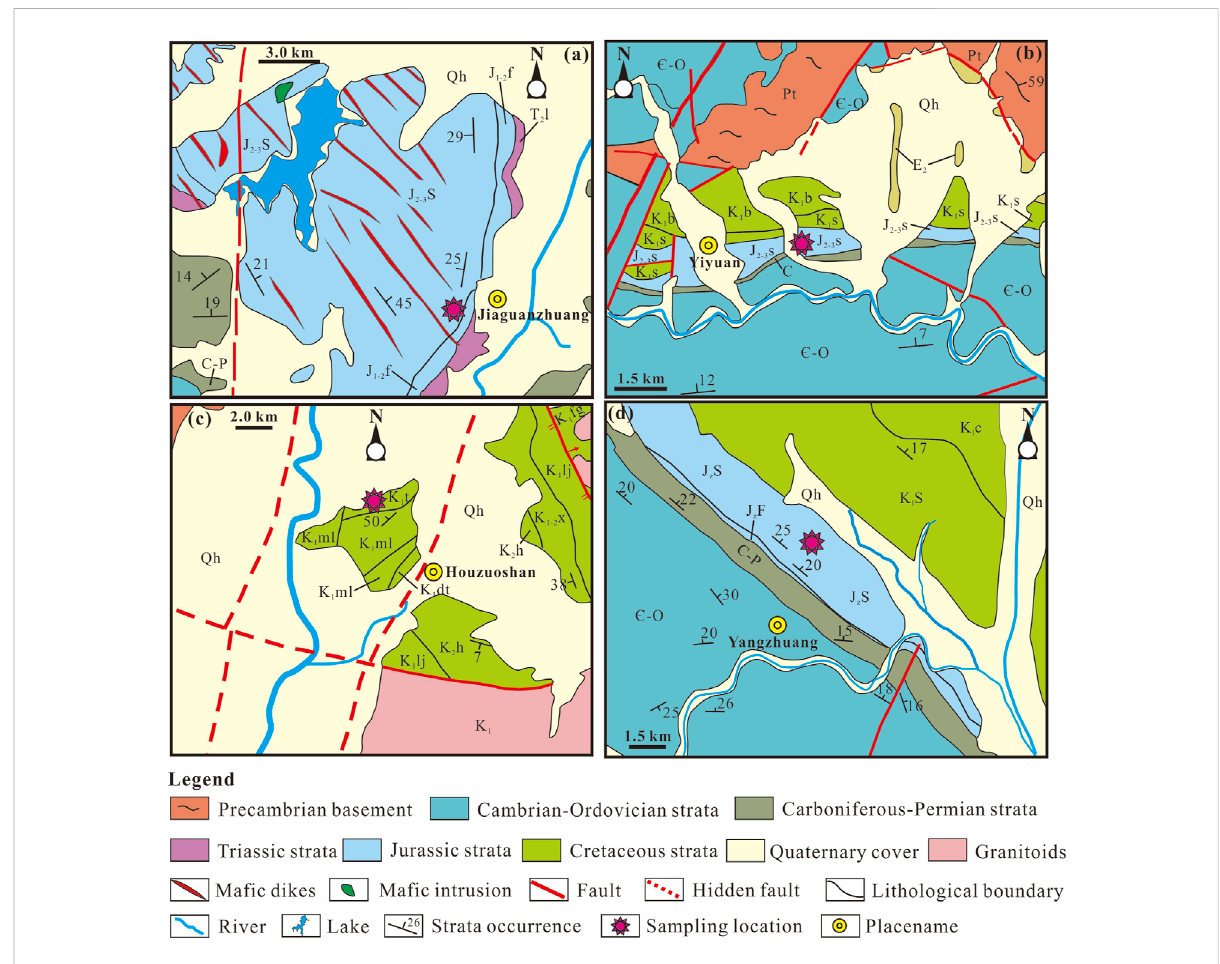
FIGURE 2 Geological and tectonic simpli fi ed map in the western Shandong and Tanlu fault zone. (A) Geological simpli fi ed map of the sample JGZ (T 2 l=Liujiagou Formation; J 1-2 f=Fangzi Formation; J 2-3 S=Santai Formation); (B) geological simpli fi ed map of the sample ZRL (J 2-3 s=Santai Formation; K 1 b=Bamudi Formation; K 1 s=Shuinan Formation); (C) geological simpli fi ed of the sample JN (K 1 fg=Fanggezhuang